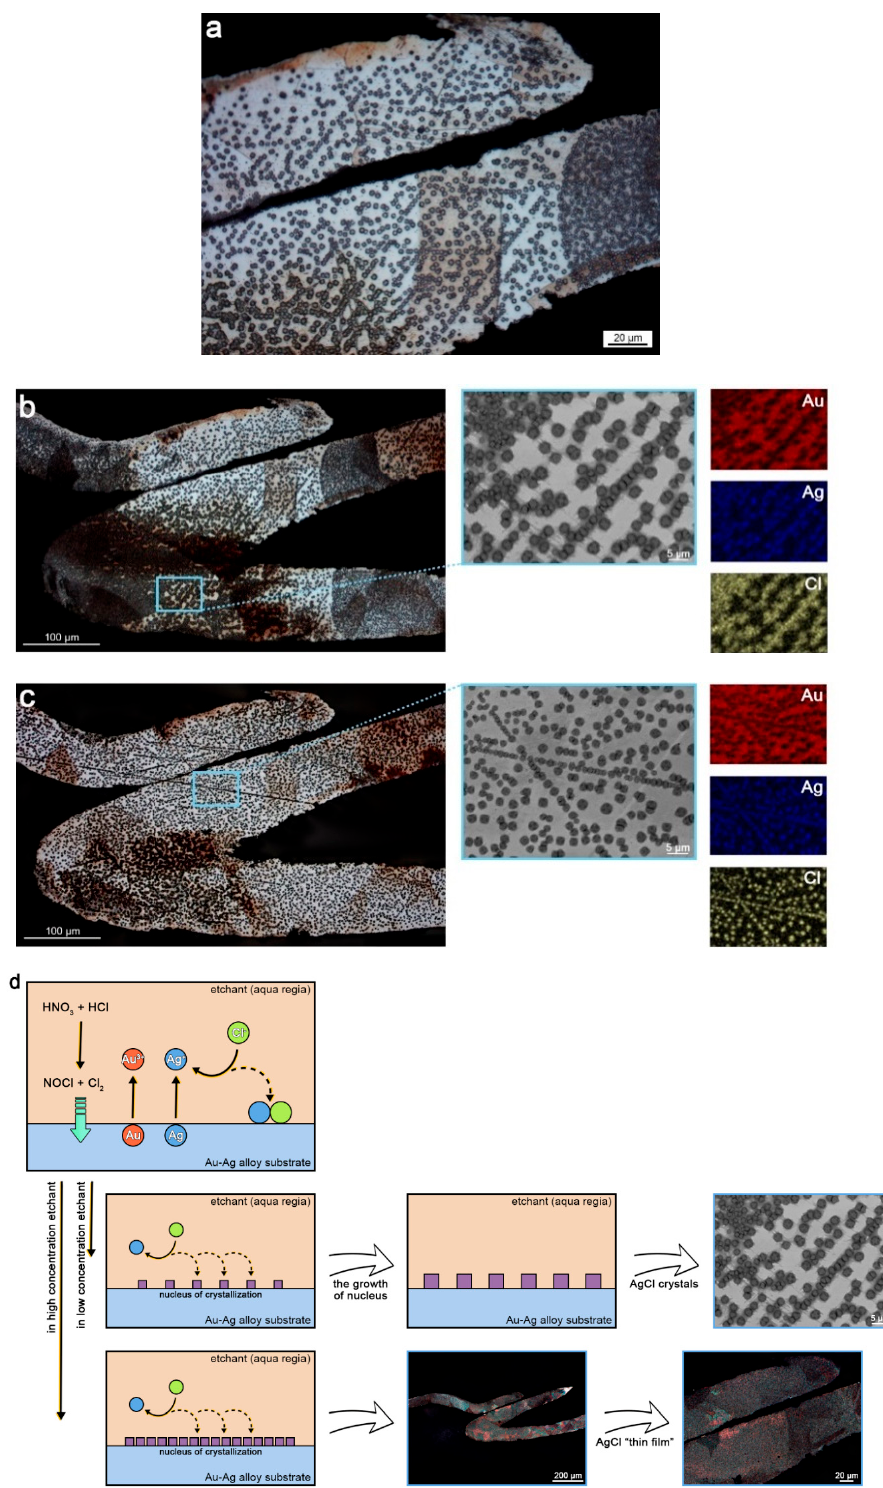
Figure 2. The mechanism of formation of the AgCl impurities. ( a ) The grain boundaries and slip lines underneath the impurities; ( b ) SEM image and EDS mapping analysis of the impurities (etchant: 6 mL HCl + 2 mL HNO 3 and diluted to 20 mL; etching duration: 100 s); ( c ) SEM image and EDS mapping analysis of the impurities (etchant: 6 mL HCl + 2 mL HNO 3 and diluted to 16 mL; etching duration: 40 s); ( d ) differences in AgCl impurity patterns when using low/high-concentration aqua regia to etch ancient gold samples.